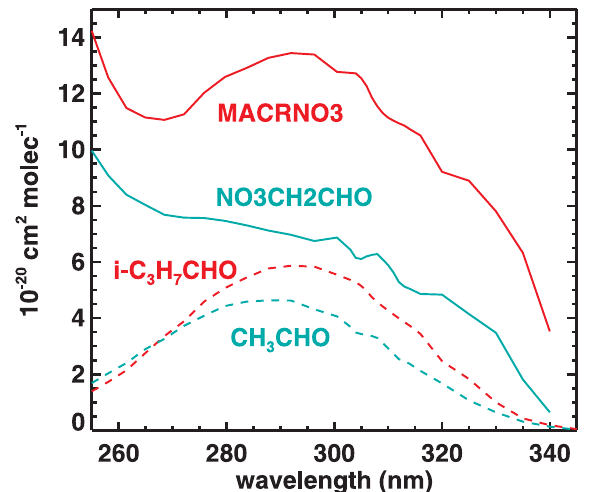
Fig. 2. Cross sections of acetaldehyde and i -butyraldehyde (dashed lines) recommended by Atkinson et al. (2006), and cross sections of ethanal nitrate (NO 3 CH 2 CHO) and MACRNO3 (cf. Table 1) es- timated using Eq. (2) (solid lines).